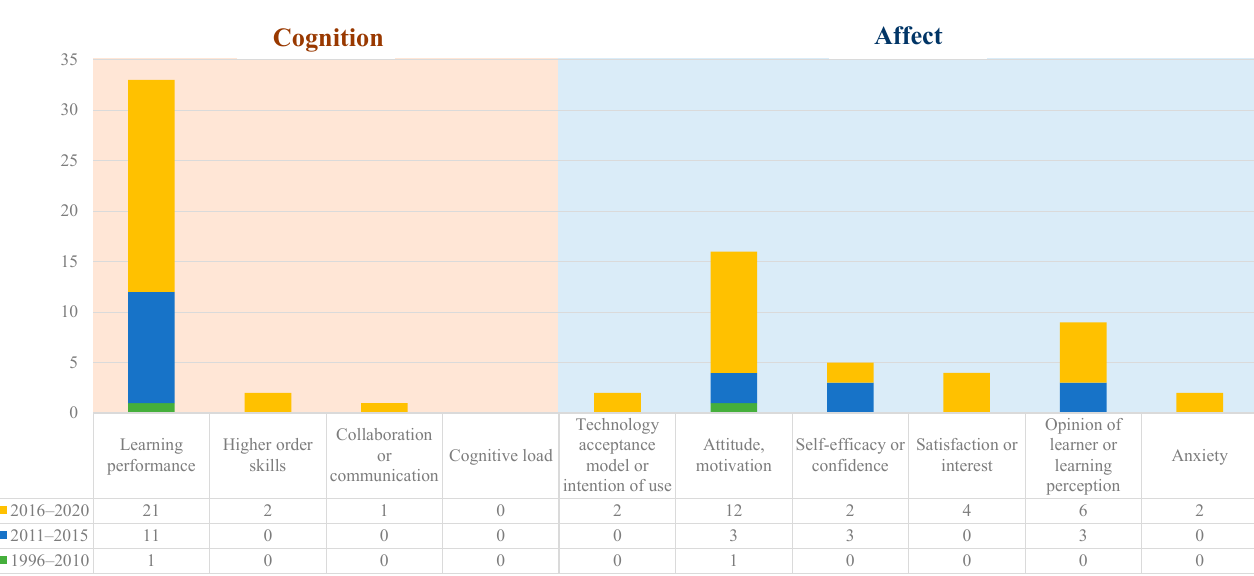
Figure 14. Research issues of AIME research in each period.